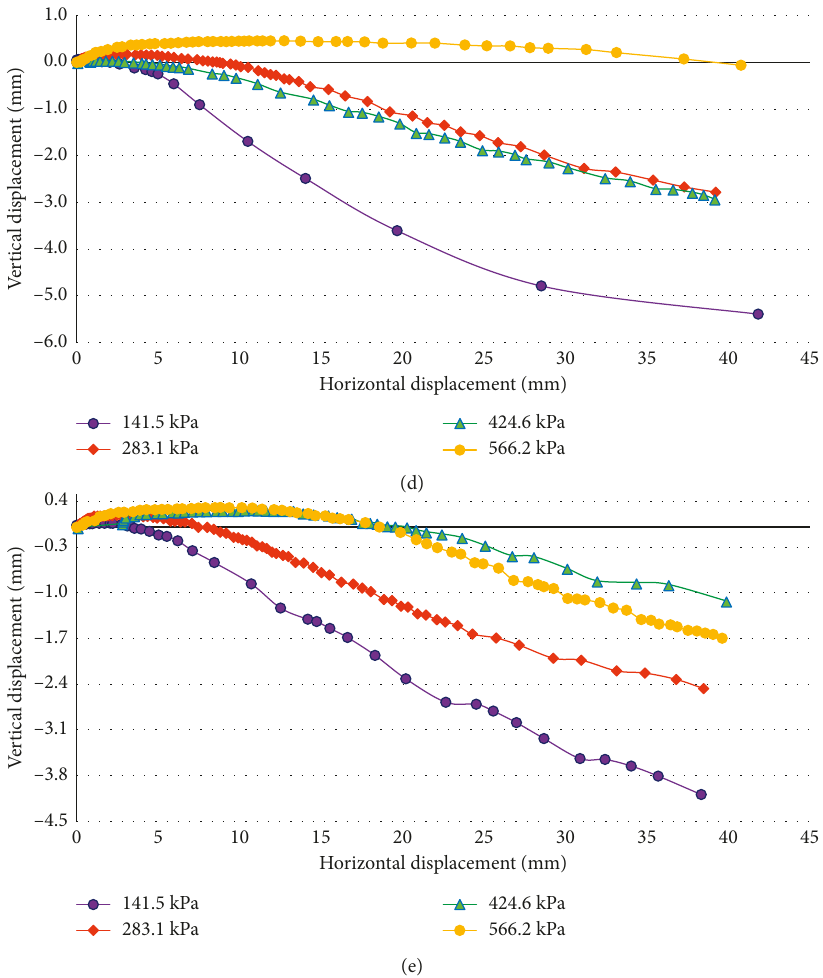
Figure 8: Vertical and horizontal displacement curves of different rock particle content: (a) RPC � 35%; (b) RPC � 45%; (c) RPC � 55%; (d) RPC � 65%; (e) RPC �